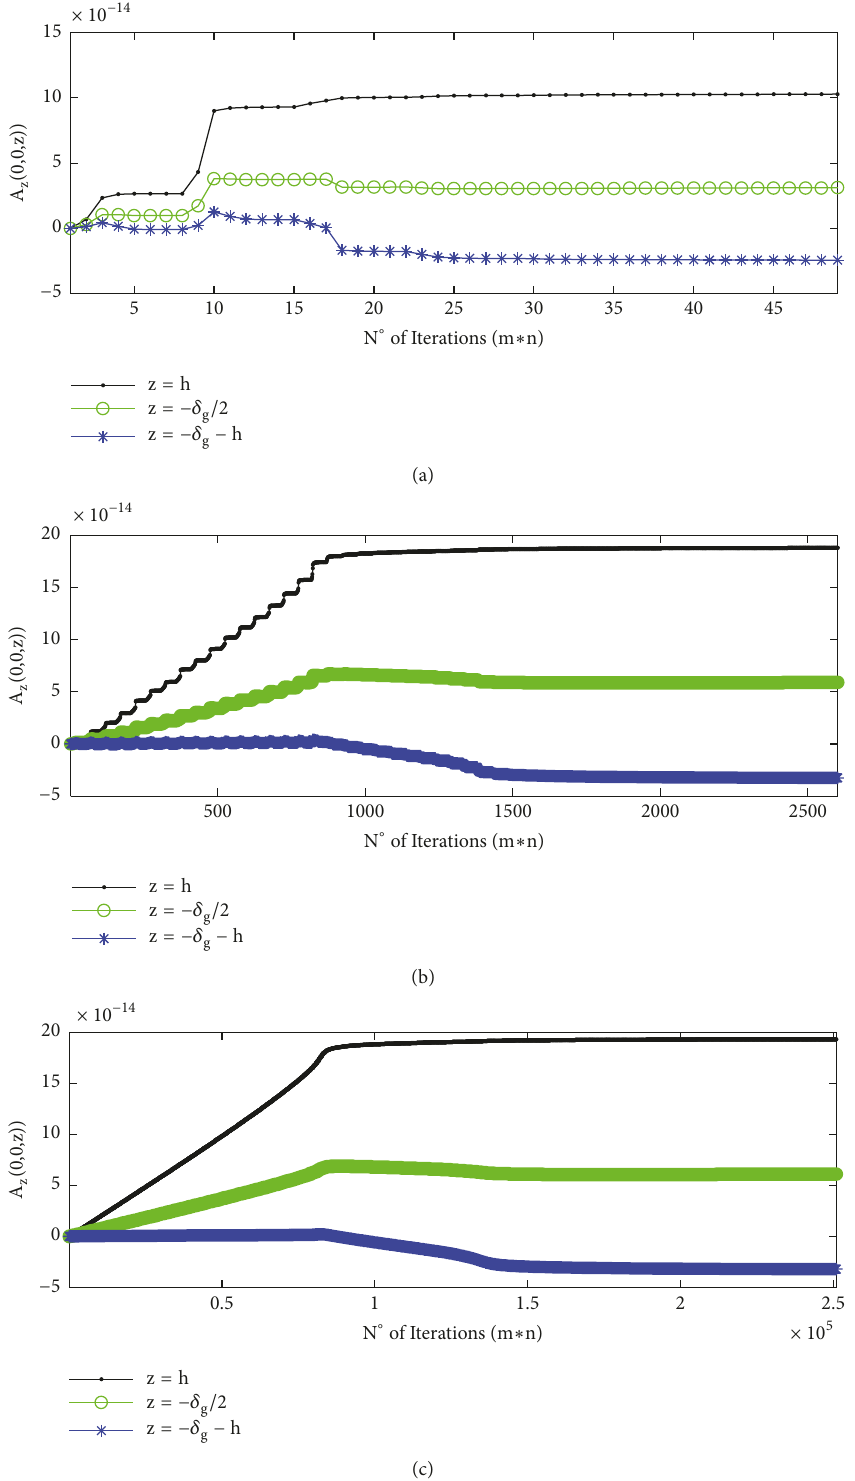
Figure 7: 𝐴 𝑧 (0,0, 𝑧) convergence for the following: (a) Δ 𝑐 = 1𝜇𝑚 , (b) Δ 𝑐 = 10𝜇𝑚 , and (c) Δ 𝑐 = 100𝜇𝑚 . In these results we set the following: 𝛿 = 50𝑛𝑚 , ℎ = 20𝑛𝑚 , 𝜃 󸀠 = 𝜙 󸀠 = 0 ∘ , and 𝜆 = 632.8𝑛𝑚 𝑔